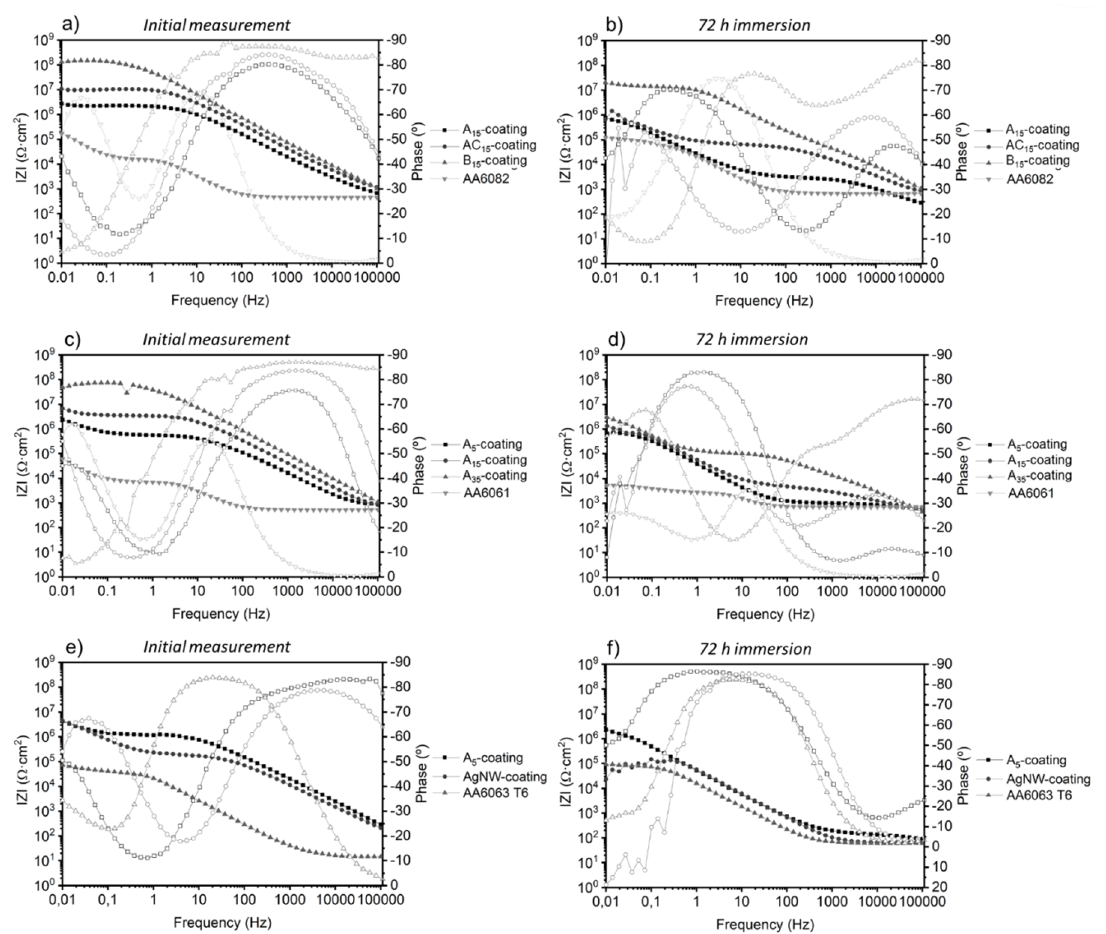
Figure 7. EIS Bode modulus and phase angle plots obtained for AA6082 ( a ), ( b ), AA6061 ( c ), ( d ) and AA6063 ( e ), ( f ) uncoated and coated with studied sols at initial time ( a , c , e ) and after 72 h ( b , d , f ) of immersion in 3.5% NaCl